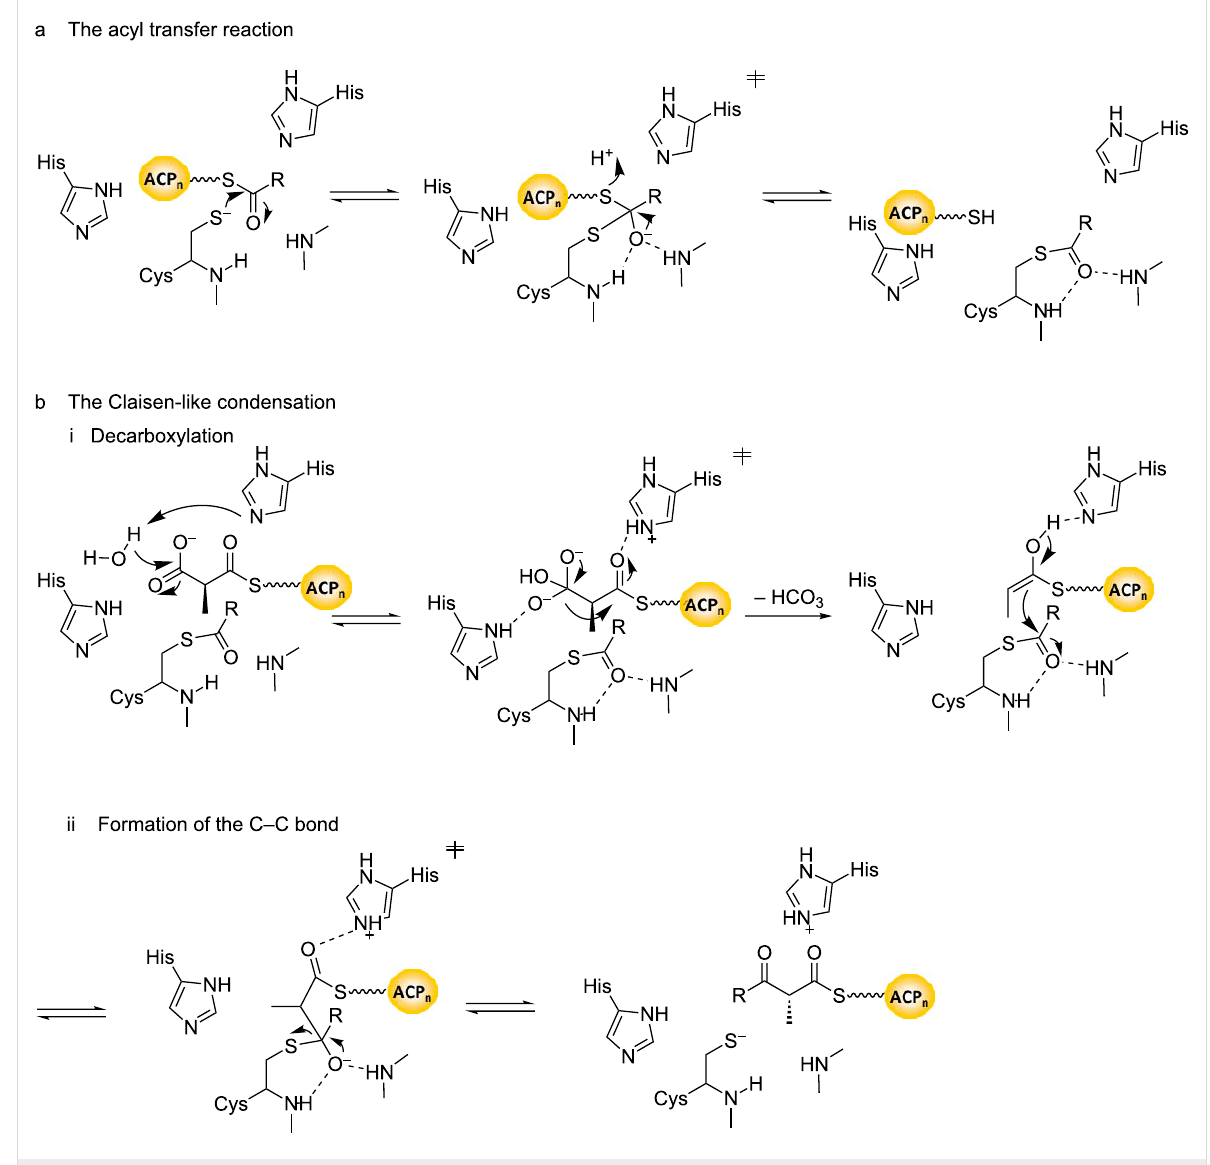
Figure 8: Proposed mechanism for KS-catalyzed chain extension, based on extrapolation from studies on homologous enzymes from animal FAS [44]. The reaction encompasses two stages overall: a) acyl transfer, and b) the Claisen-like condensation. From the stereochemical perspective, the important aspect of the mechanism is that the C-2-methyl stereochemistry is set by the direction of attack of the enolate nucleophile on the acyl en- zyme carbonyl (reaction bii). (Although several elements of this mechanism differ from that proposed more recently in [45], including the roles of the His residues in the acyl transfer reaction, and whether decarboxylation proceeds with initial attack by a water molecule, these do not have stereo- chemical consequences).